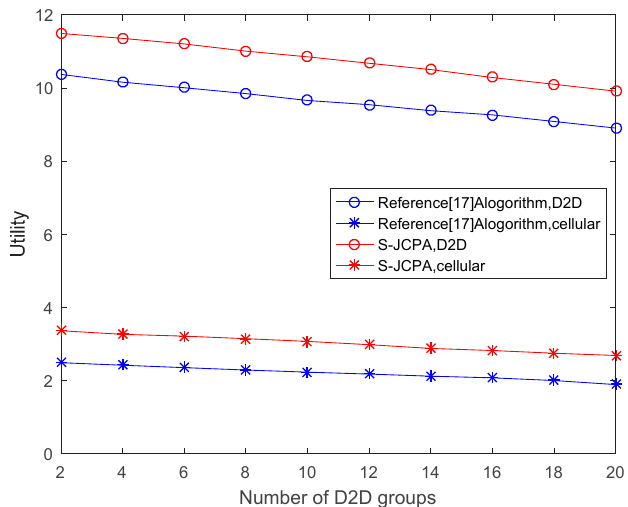
Figure 3. D2D (Device-to-device) and cellular’s utility for different algorithms with different numbers of D2D groups, M = 20, S k m , n ∼ ( 0, 1 )